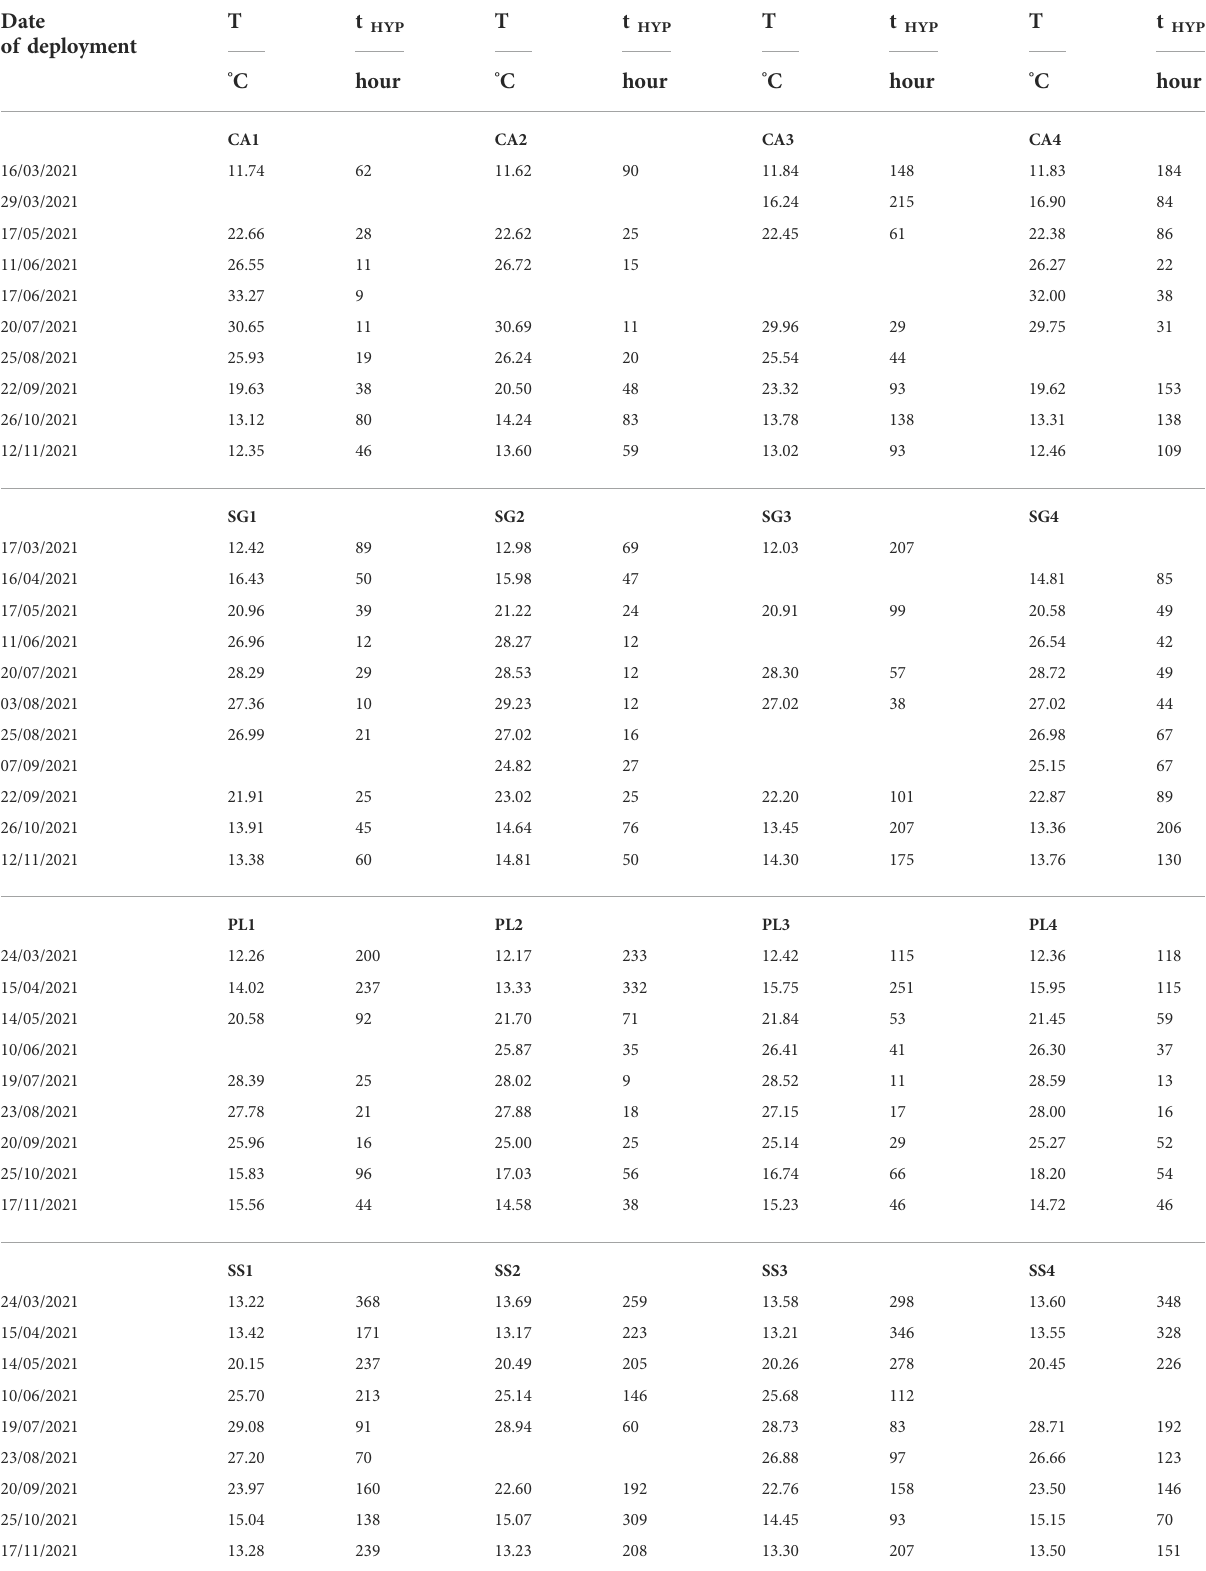
TABLE 4 Estimated time elapsing (t HYP ) from the DO saturation to the limit of hypoxia values in the whole water column, due to the SOD T rate at the conditions simulating the MOSE closure. Date of